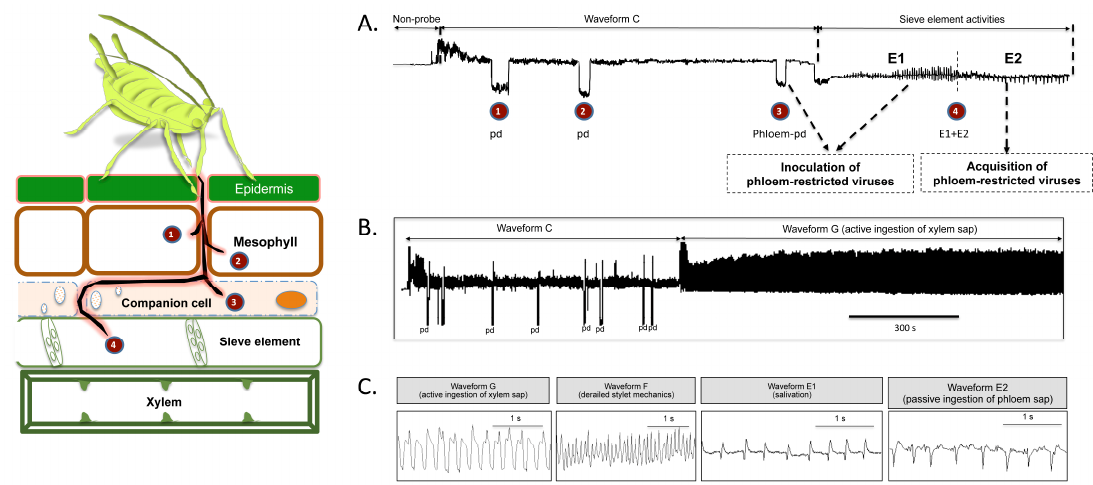
Figure 1. Electrical-penetration-graph (EPG) recording of green peach ( Myzus persicae ) on Physalis floridana Rydb. ( A ) Overview of electrical-penetration graphs in which di ff erent numbers indicate specific EPG patterns where the aphid inserts stylets into a specific cell. ( 1 , 2 ) Potential drops (pd) where the aphids insert their stylets in mesophyll cells. ( 3 ) Phloem-pd; aphid inserts stylets in companion or sieve element cells. ( 4 ) Stylets penetrate a sieve element. Patterns ( 3 ) and ( 4 ) are involved in the transmission of phloem-restricted viruses. Inoculation of phloem-limited viruses occurs during phloem-pd and E1 waveforms while the acquisition occurs during Waveform E2. np, nonprobing behavior; C, intercellular apoplastic stylet pathway; pd, intracellular punctures; phloem-pd, brief phloem punctures on companion or sieve elements cells. ( B ) EPG recording showing intercellular apoplastic stylet pathway (Waveform C), including some pds, and ending on active intake of xylem sap (Waveform G). ( C ) Detail of specific waveforms. G, active intake of xylem sap; F, derailed stylet mechanics; E1, salivation into phloem sieve elements; E2, passive phloem sap uptake from sieve